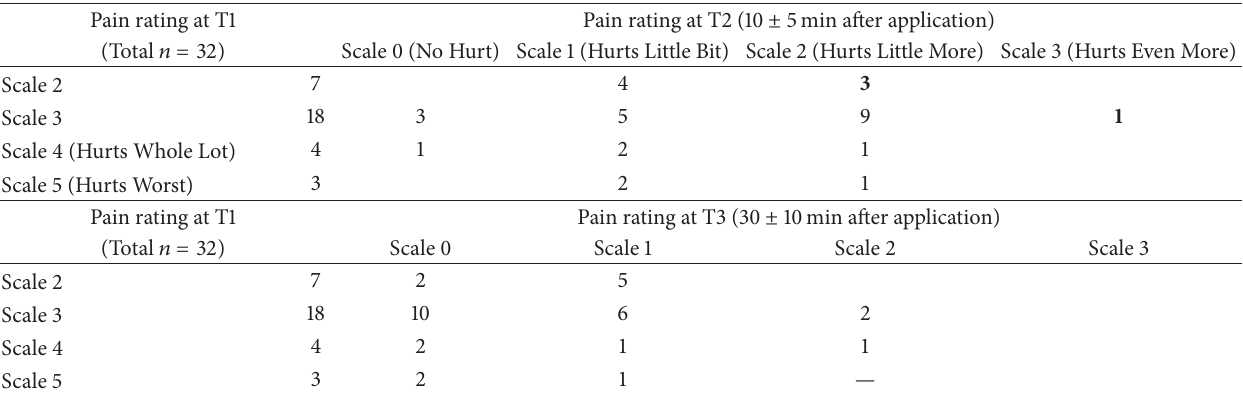
Table 3: Pain rating in age group II: change between T1 (baseline) and T2 (10 ± 5 min after application) or T3 (30 ± 10min after application). Pain rating at